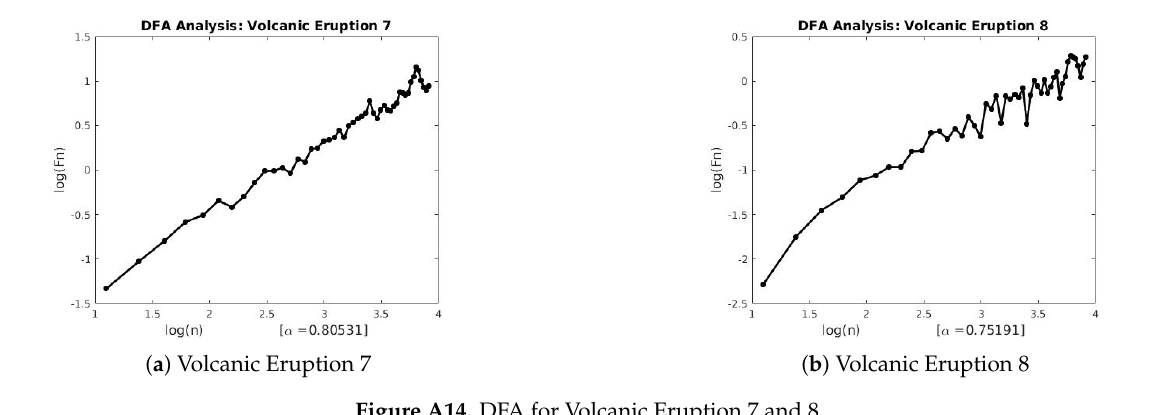
Figure A14. DFA for Volcanic Eruption 7 and 8.